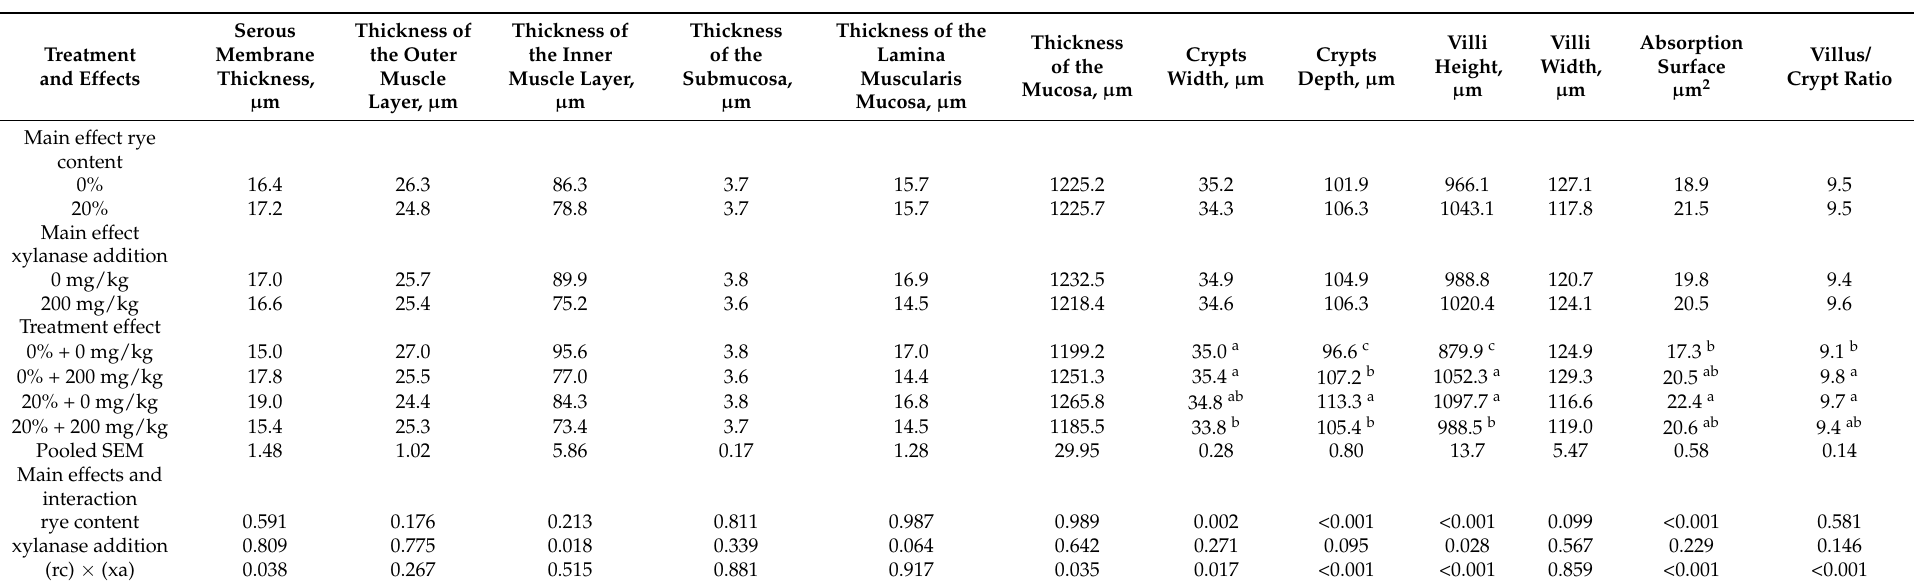
Table 3. Histomorphometric properties of the duodenum of male, Ross 308 broiler chicks following the 42-day experimental period.